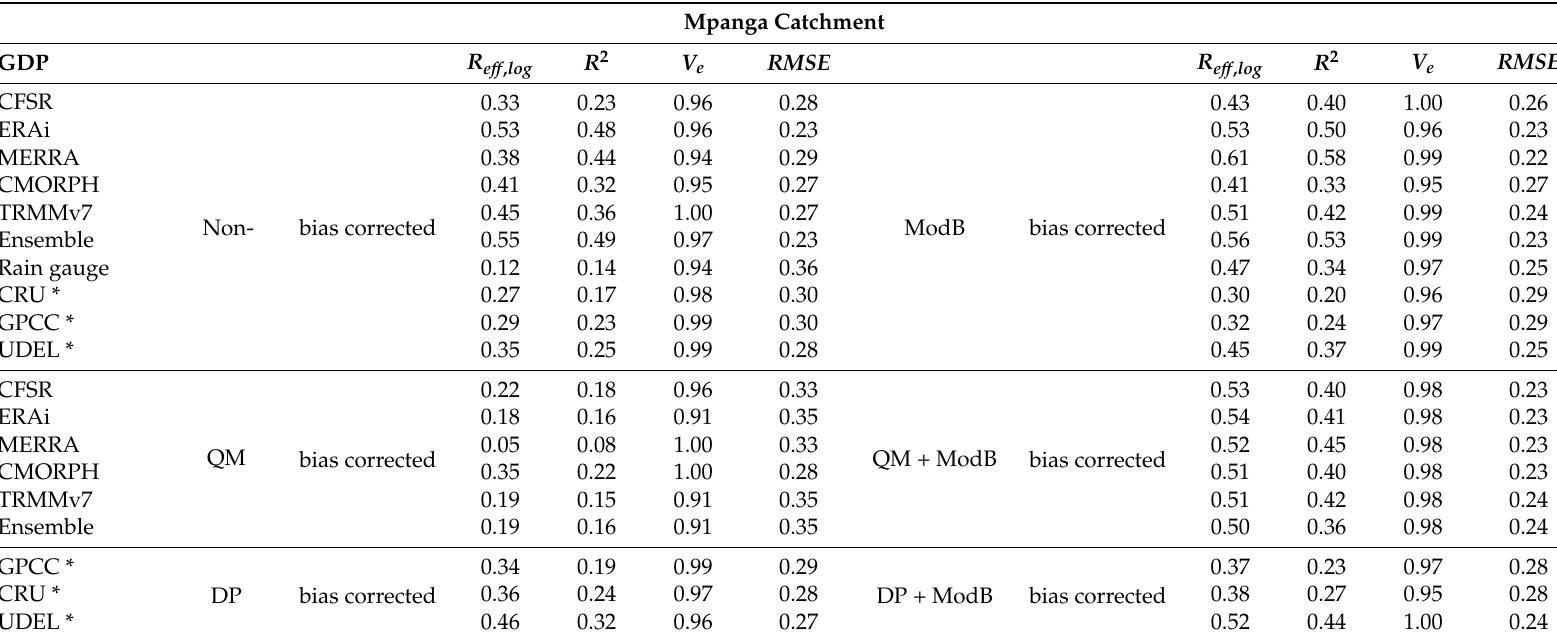
Table 3. Performance scores for MC discharge simulations. Performance is shown as R eff , log , R 2 , V e , and RMSE values for each bias correction technique